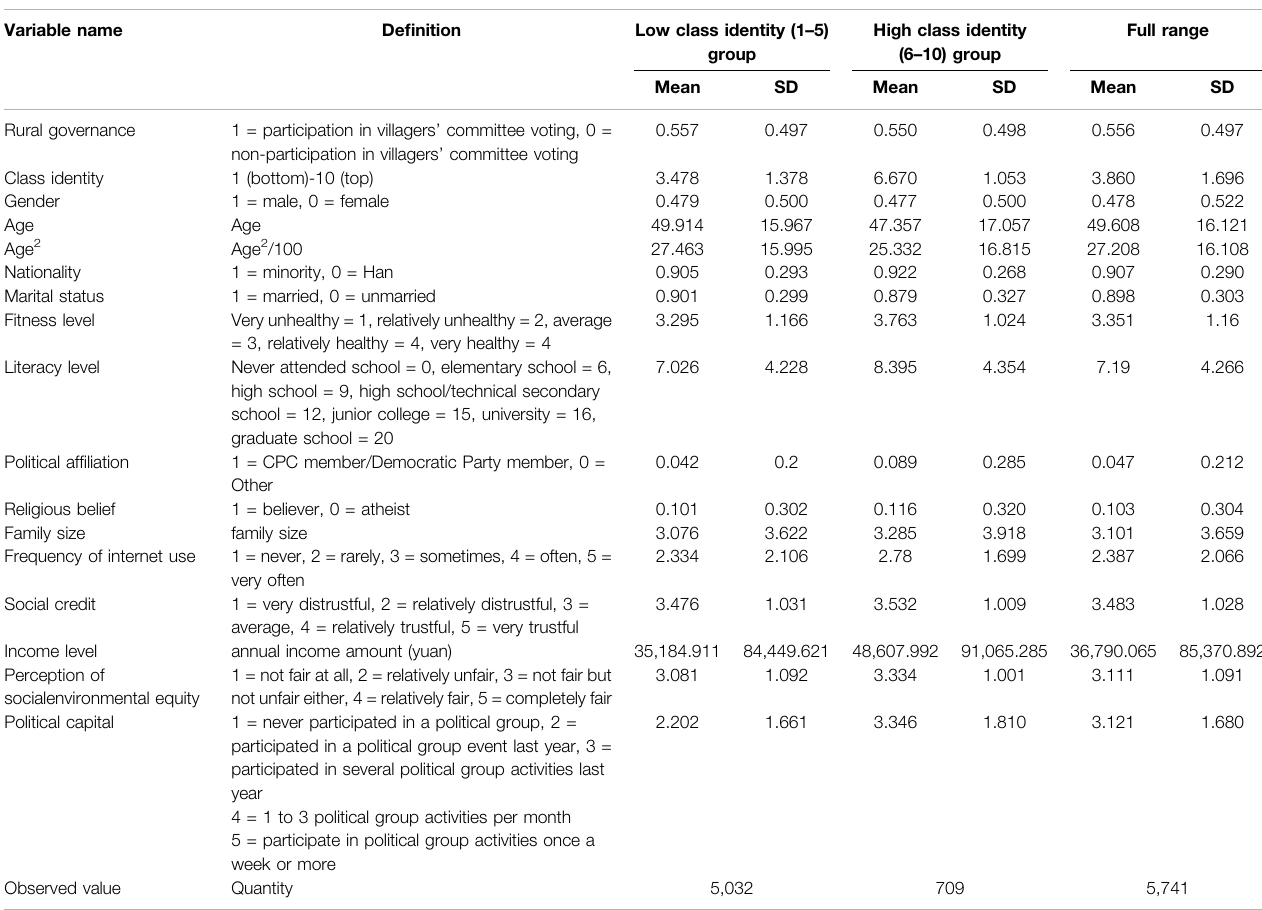
TABLE 1 | Key characteristics of our